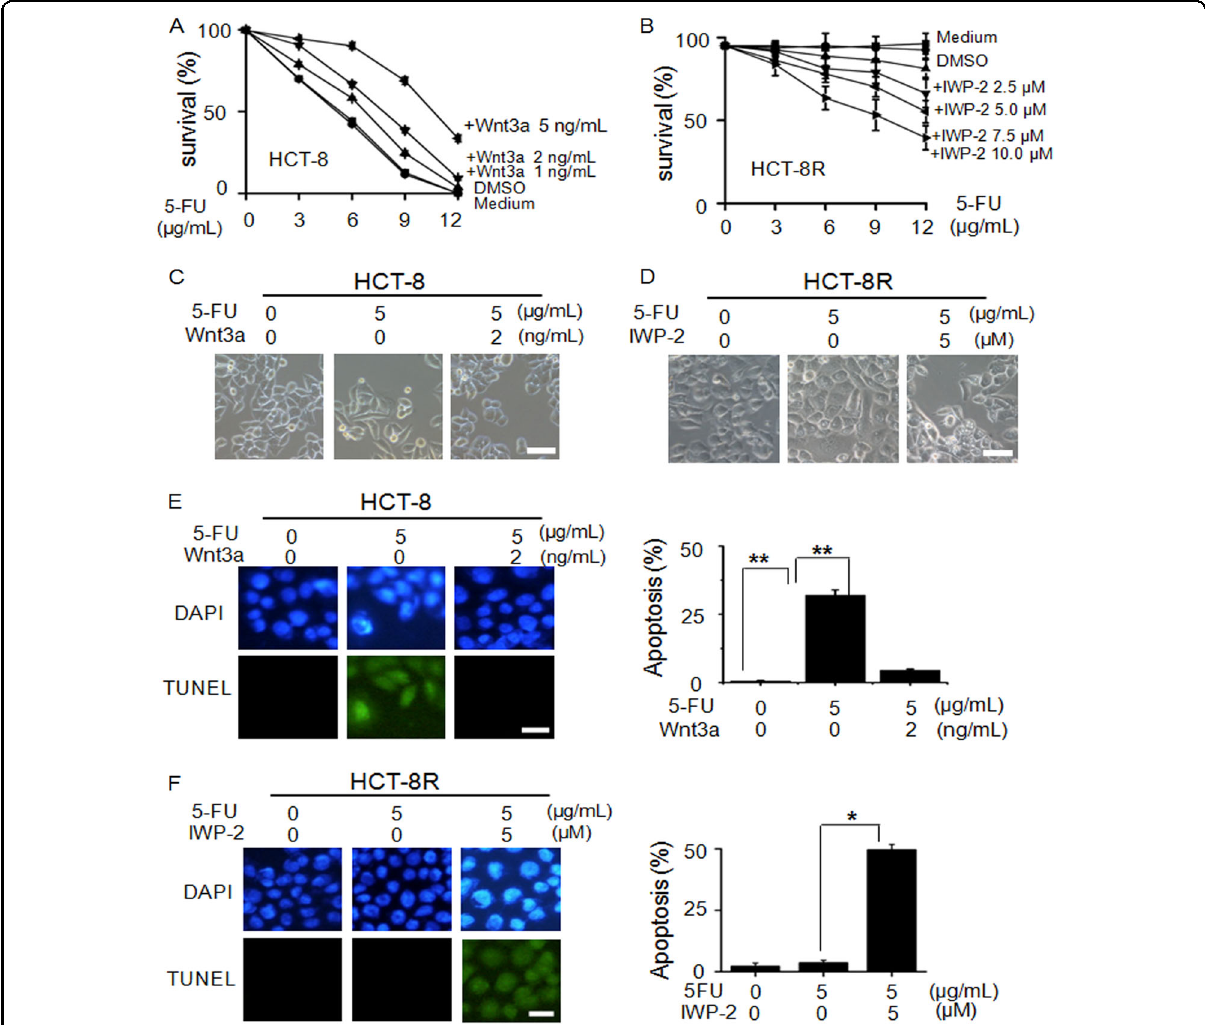
Fig. 5 Regulation of the cell survival rate by Wnt activity in HCT-8R cells. a Wnt3a treatment improved the HCT-8 cell survival rate in 5-FU- containing medium. b Inhibition of the Wnt pathway decreased the cell viability of HCT-8R cells. c The cell morphology of HCT-8 cells treated with Wnt3a. Scale bar, 100 µm. d The cell morphology of HCT-8R cells treated with Wnt inhibitor. Scale bar, 100 µm. e TUNEL assay proved the enhanced resistance of Wnt3a-treated HCT-8 cells in 5 µg/mL 5-FU-contained medium. Scale bar, 20 µm. ** P < 0.01. f TUNEL assay proved the apoptosis of HCT- 8R cells induced by Wnt inhibitor. Scale bar, 20 μ m. * P <